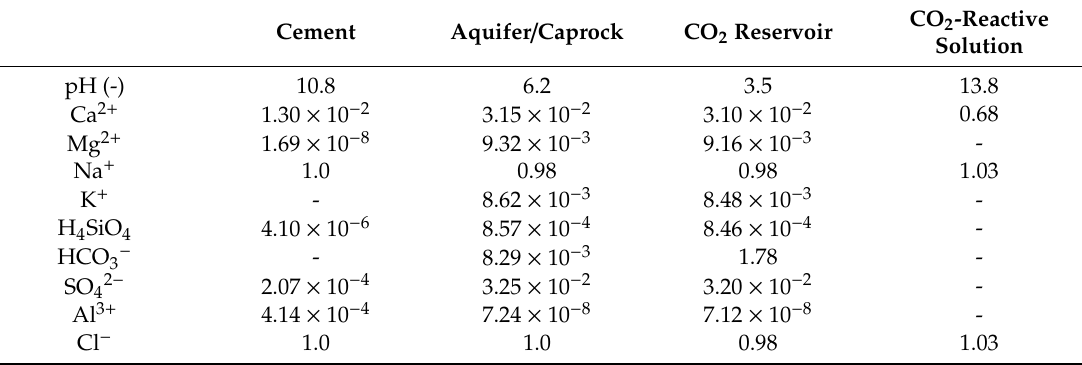
Table 4. Initial composition of the di ff erent fluids, dissolved species in mol /